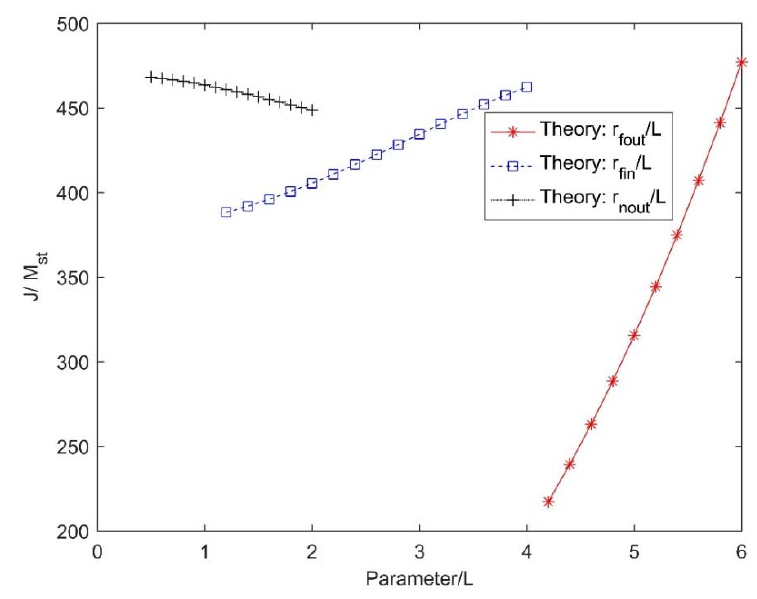
Figure 3. Parametric curves for the ball ‐ screw inerter. L is the lead of its screw.